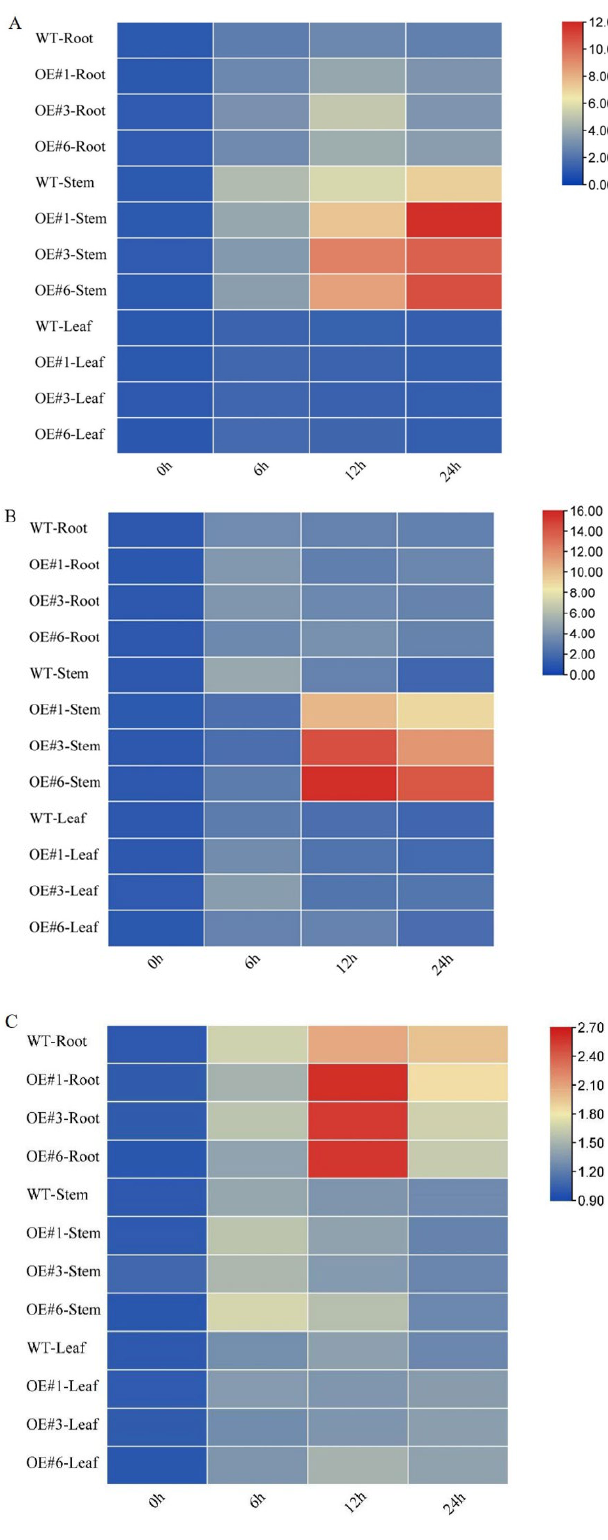
Figure 4. Tissue-specific relative gene expression of GmSOS1 ( A ), GmSOS2a ( B ), and GmSOS2b ( C ) under normal and salt-stressed conditions. Note: A group–group significance analysis was per- formed, and each treatment (OE#1, OE#3, and OE#6) was compared to WT. All values are presented as the mean ± SD of three independent